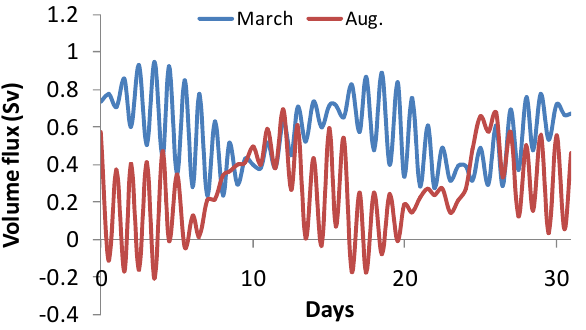
Fig. 21. The short-time variations of the outflow transports during March and August. The data are plotted in half day intervals.